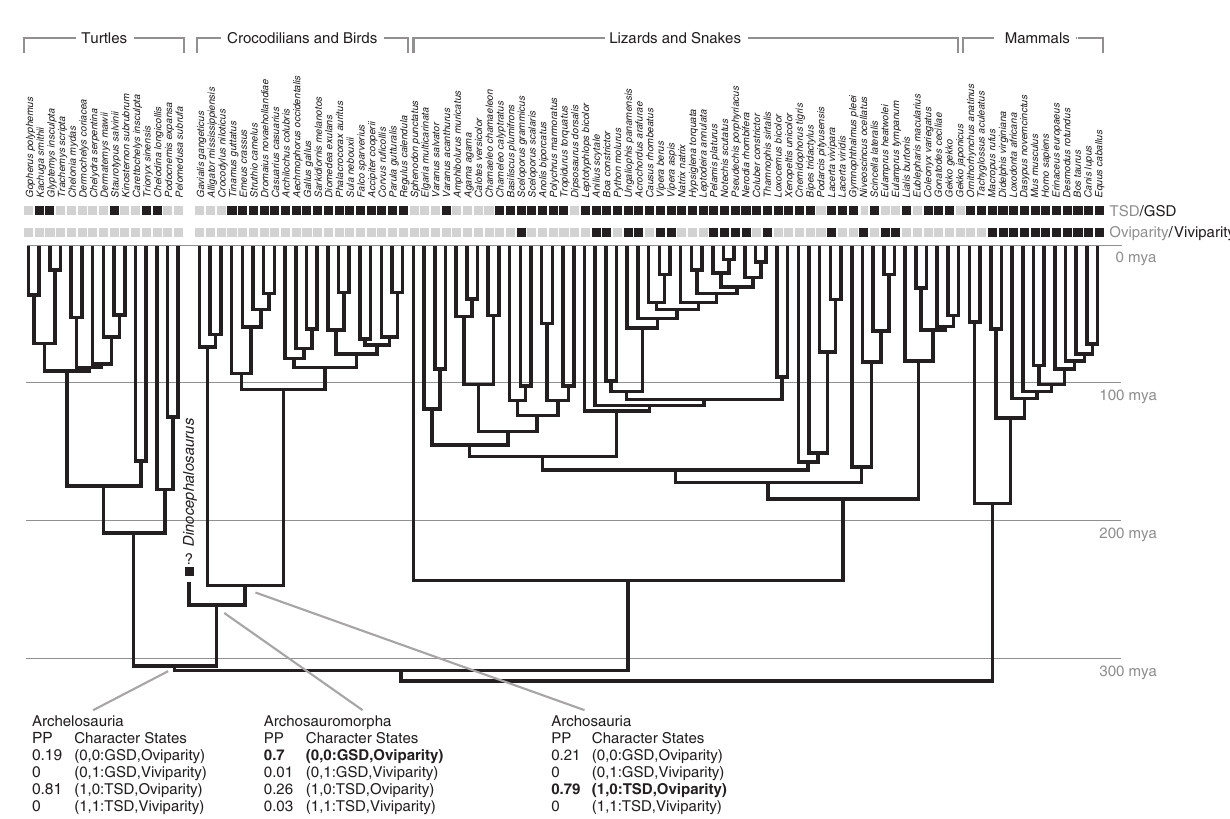
Figure 5 | Distribution of sex determination mechanism and reproduction mode. The stratogram summarizes all key amniote clades. GSD, genotypic sex determination; TSD, temperature sex determination. Posterior probabilities of ancestral states for Archelosauria, Archosauromorpha and Archosauria are given. The highest posterior probability is